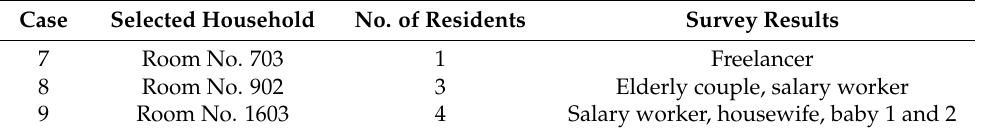
Table 12. Survey results of residents consuming more than the average heating energy.